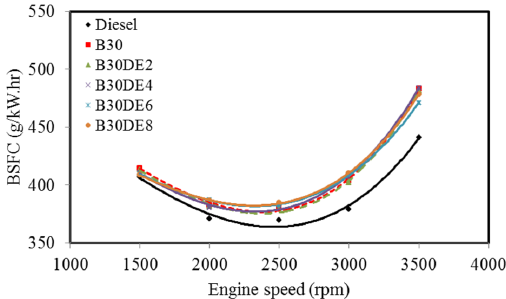
Figure 9. Variation of engine brake specific fuel consumption (BSFC) for different diethyl ether additive ratios.